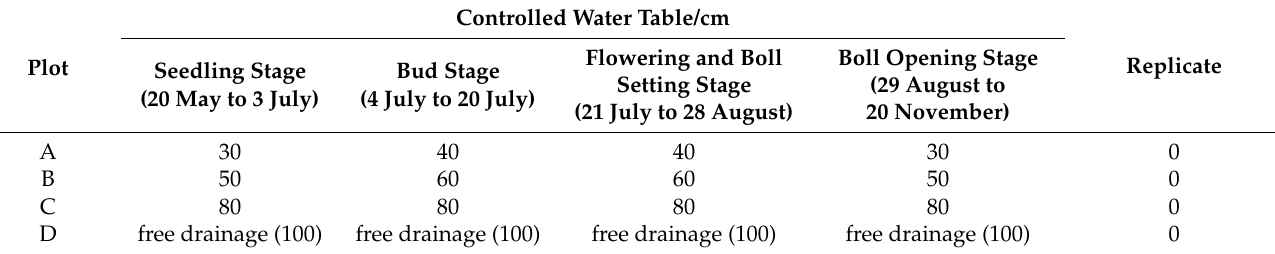
Table 1. Controlled water table design in the plots.